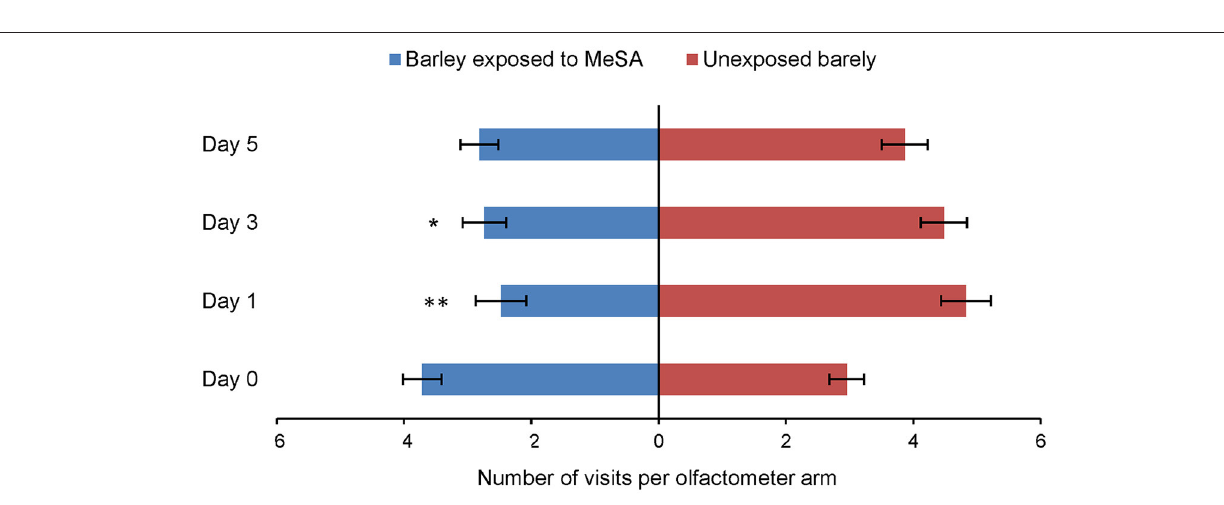
MeSA-exposed plants, but not significantly. Duration of probing did not differ between exposed and unexposed plants ( p = 0.57) but in exposed plants significantly longer time was spent in the path period (about 40%) ( p = 0.014) and less time in the feeding period (E2) (about 29%) compared to unexposed plants (26 and 50% respectively). Number of probes before the 1st feeding attempt (1st E1) was significantly higher in MeSA- exposed plants ( p = 0.042). The duration of the xylem feeding period was significantly longer and the number of xylem feeding periods (G) was significantly higher in MeSA-exposed plants ( p = 0.034; p = 0.008 respectively). Three days after removal of MeSA (Day 3) the duration of non-probing period was significantly longer ( p = 0.024)